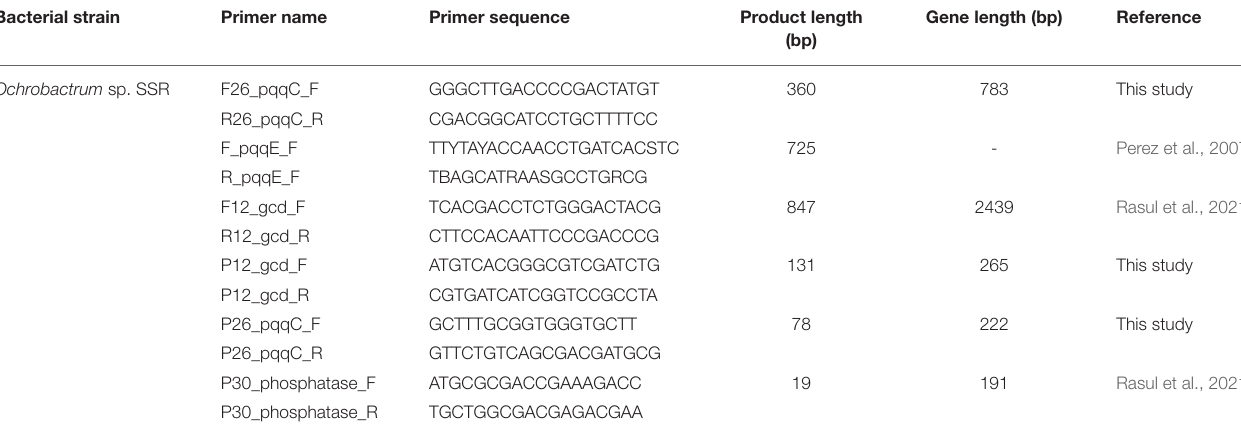
TABLE 1 | The qPCR primers for quantification of genes encoding for proteins involved in PS, i.e., gcd, pqqC , and pho . Bacterial strain Primer name Primer sequence Product length